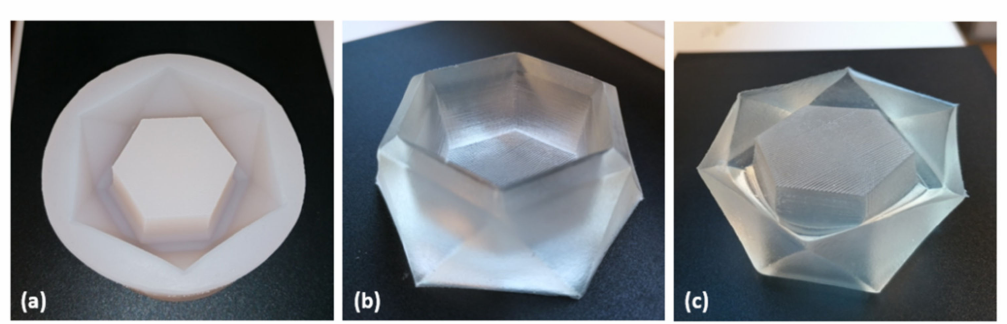
Figure 5. ( a ) Silicone rubber mold with four centimeters depth. ( b ) Photofrontally-cured specimen of resin R-4000_50 with a total weight of 60 g. ( c ) The grid-like structure of the hexagonal surface is accurately reproduced. The surface exposed to air appeared slightly sticky due to oxygen inhibition, whereas all other areas appeared dry and